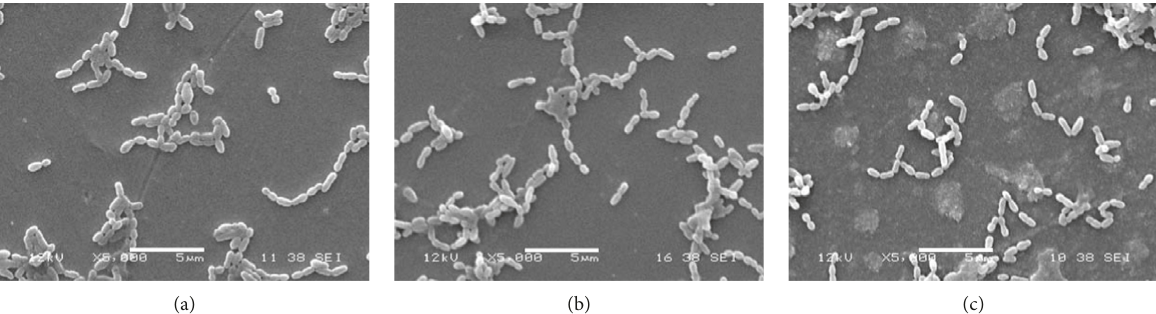
Figure 8: Bacterial colonization at 8h on SS polished (a), SS coated (b), and SS micropatterned (c). The bar is 5 µ m.